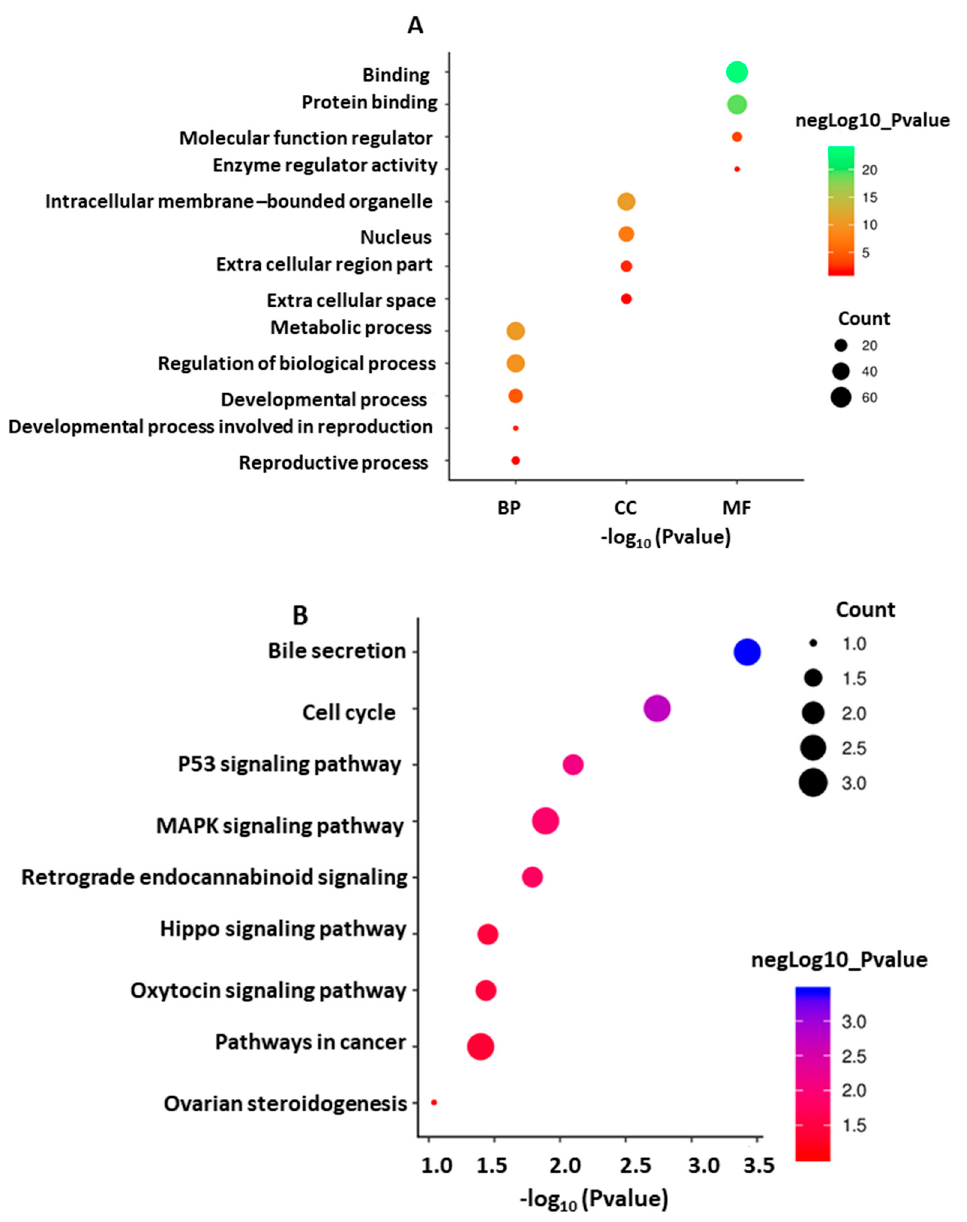
Figure 14. The bubble chart of ( A ) gene ontology (GO) terms and ( B ) Kyoto Encyclopedia of Genes and Genomes (KEGG) pathways of the selected genes.